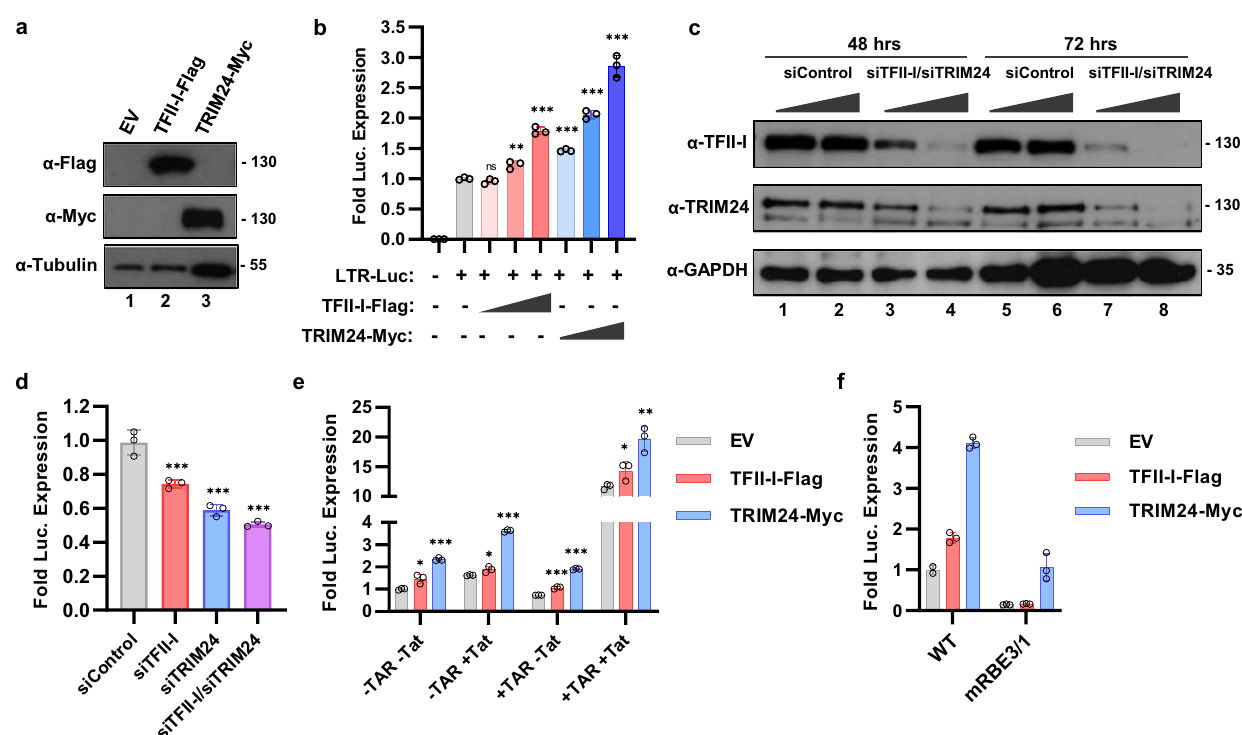
Fig. 3 HIV-1 LTR transcription is activated by TRIM24. a HEK293T cells were transfected with plasmids expressing TFII-I-Flag (lane 2), TRIM24-Myc (lane 3), or an empty vector (EV, lane 1). Lysates were analyzed by immunoblotting against Myc, Flag, or Tubulin as indicated. b HEK293T cells co- transfected with an LTR-Luciferase reporter plasmid and TFII-I-Flag or TRIM24-Myc expression vectors were analyzed for luciferase activity ( n = 3, mean ± SD). c HEK293T cells were transfected with siRNA against TFII-I or TRIM24 (lanes 3-4 and lanes 7-8). Lysates were collected 2- (lanes 1 – 4) and 3 days (lanes 5 – 8) post transfection and analyzed by immunoblotting with anti-TRIM24, anti-TFII-I, or anti-GAPDH antibodies as indicated. Loading control was performed on an individual gel. d HEK293T cells co-transfected with an LTR-Luciferase reporter plasmid and siRNA targeting TFII-I and/or TRIM24 were analyzed for luciferase expression ( n = 3, mean ± SD). e Luciferase assay was performed using HEK293T cells co-transfected with an LTR-Luciferase reporter plasmid and TRIM24-Myc and/or TFII-I-Flag expression vector, in the presence ( + Tat) or absence ( − Tat) of Tat expression vector. The LTR- Luciferase reporter contained ( + TAR) or lacked the TAR ( − TAR) stem loop region ( n = 3, mean ± SD). f Wild-type LTR-Luciferase reporter or LTR- Luciferase reporter with mutated RBE3 and RBE1 elements (mRBE3/1) were co-transfected with an empty vector plasmid (EV) or plasmids expressing TFII- I-Flag or TRIM24-Myc ( n = 3, mean ±